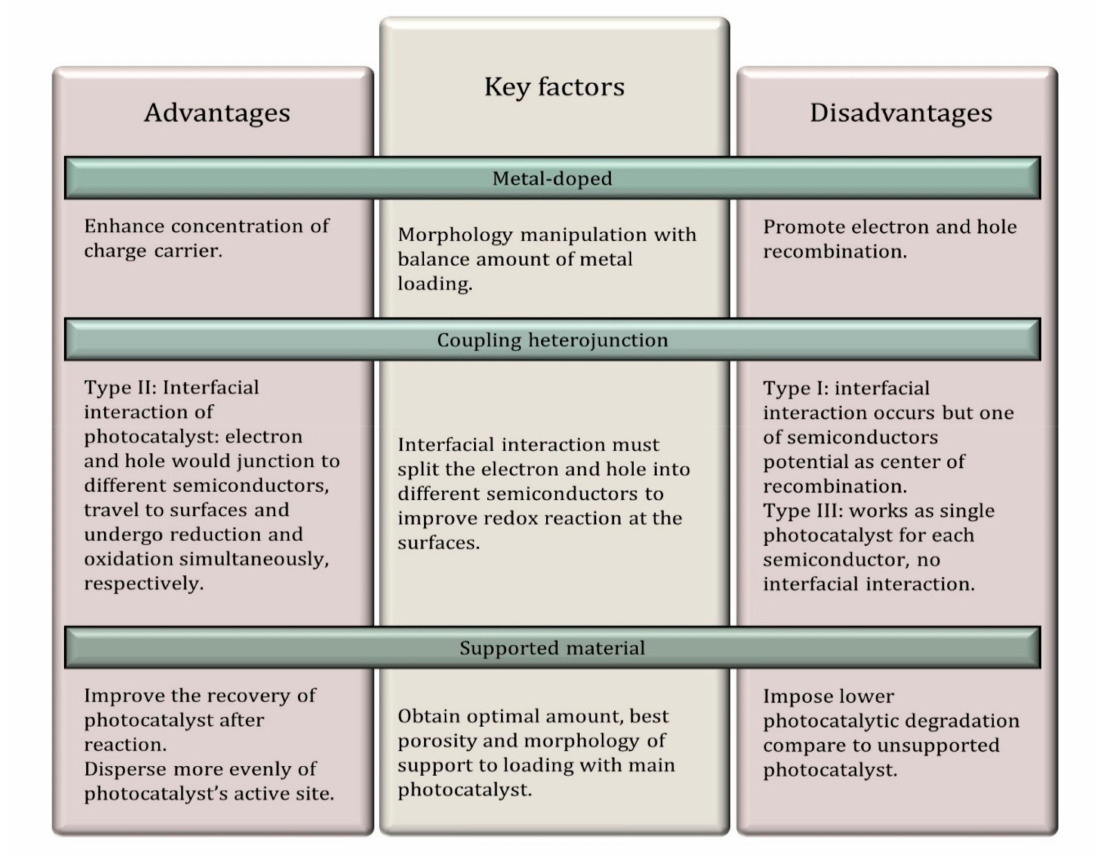
Figure 17. Di ff erent types of hybridization photocatalyst and the key factor to